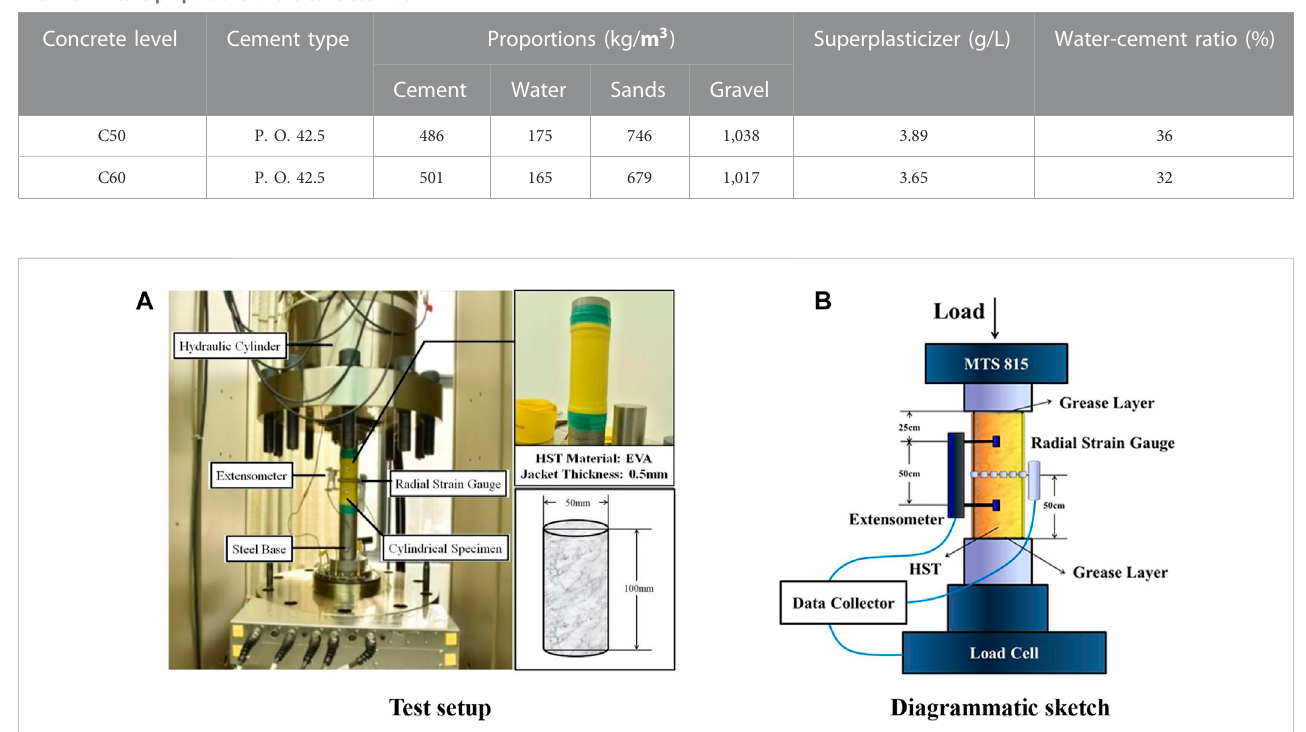
TABLE 5 Mixture proportions of the concrete matrix.